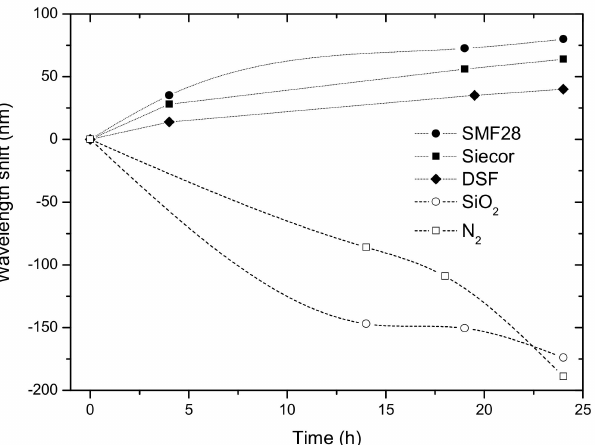
Figure 8. Time dependence of the resonant wavelength at 1000 ◦ C. Reprinted with permission from ref. [97]. © 2021 IEE.